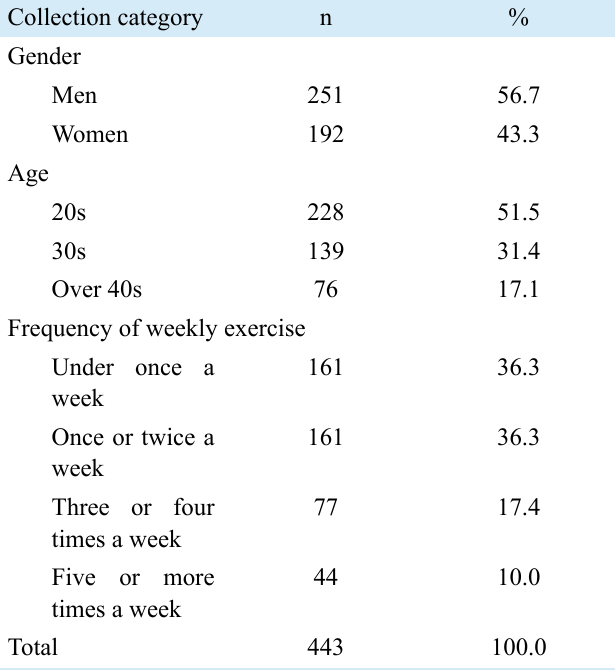
TABLE 1. The demographic characteristics of the study